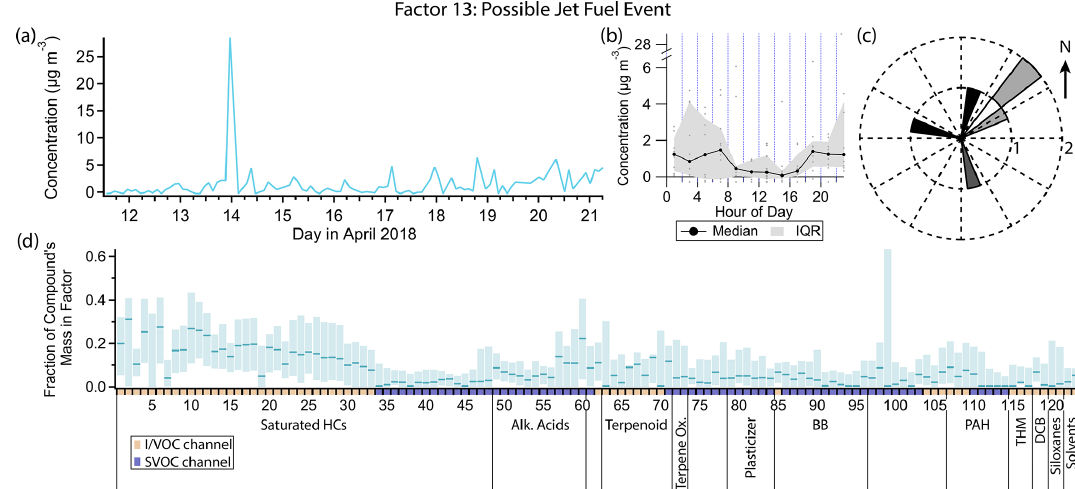
Figure 19. (a) Factor 13 timeline. (b) Diurnal profile for Factor 13. (c) Rose plot showing correlation of elevated emissions and wind direction. (d) Factor 13 composition profile. See Fig. 4 description for further information on how to read this